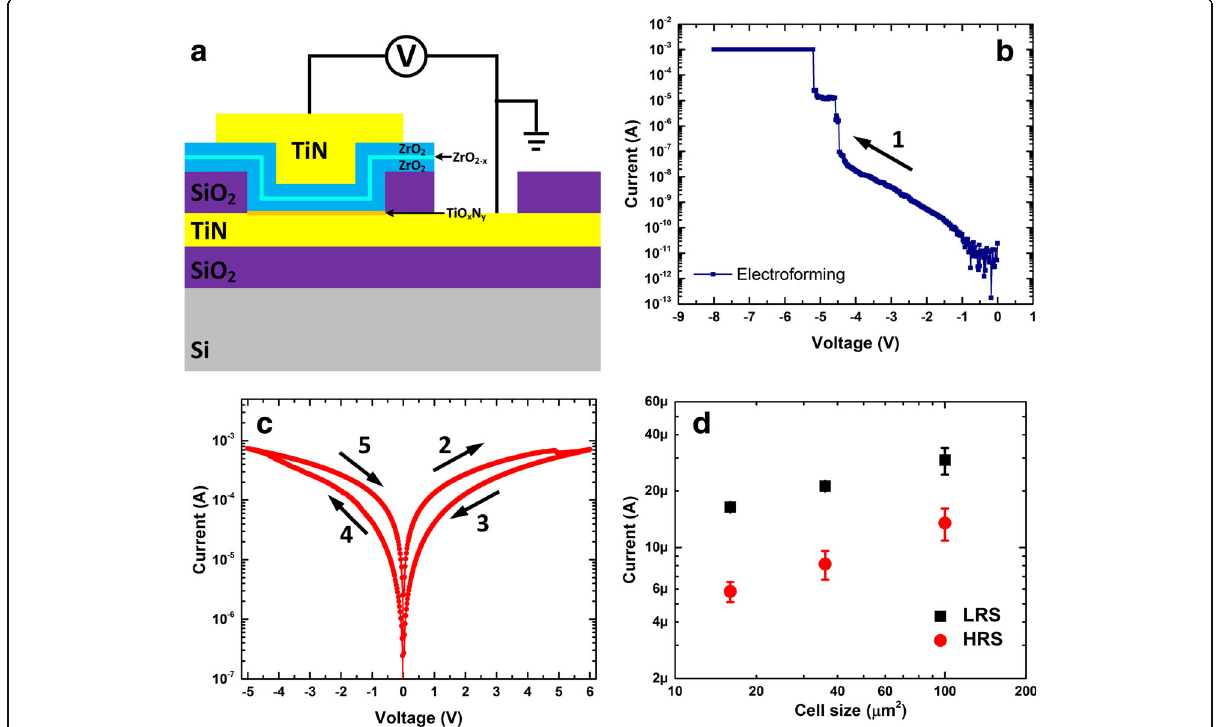
Fig. 4 a Schematic of the tri-layer TiN/ZrO 2 /ZrO 2 − x /ZrO 2 /TiN memory. b I – V characteristics of the electroforming process for the TiN/ZrO 2 /ZrO 2 − – V characteristics of the interfacial switching after forming. d Current as the function of device size for both HRS/LRS in the x /ZrO 2 /TiN device. c I interfacial switching